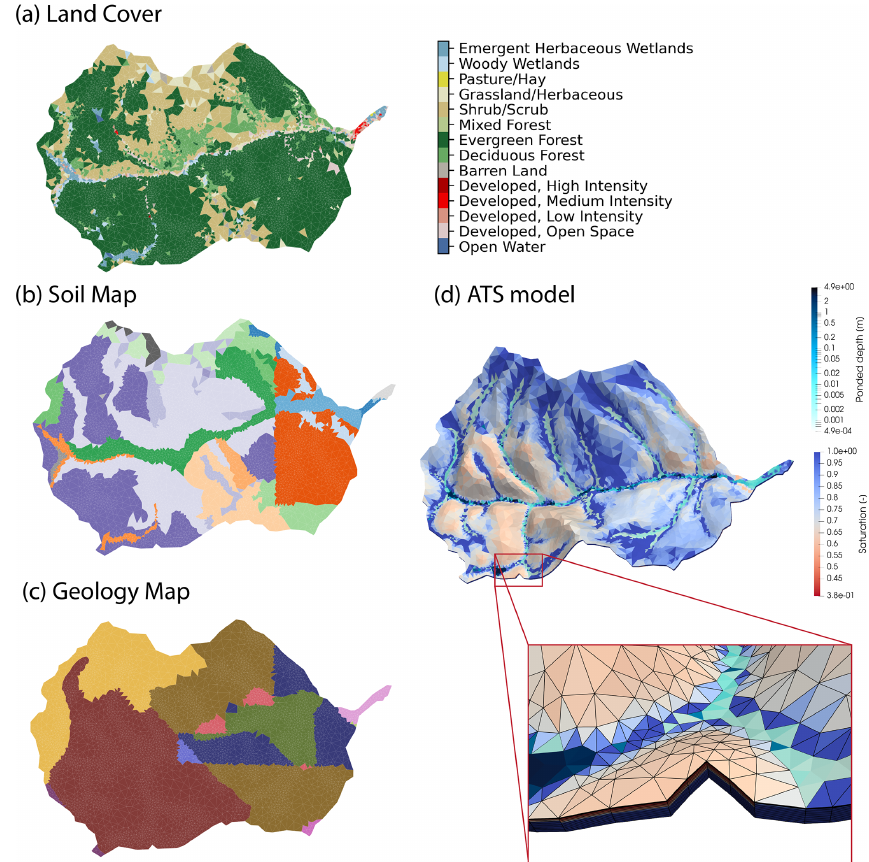
Figure 2. (a) Land cover, (b) soil map, and (c) geology map of Coal Creek Watershed that are generated from Watershed Workflow. (d) ATS- simulated surface ponded depth and soil saturation on 1 October 2018. The zoomed-in plot shows the 3D unstructured triangular